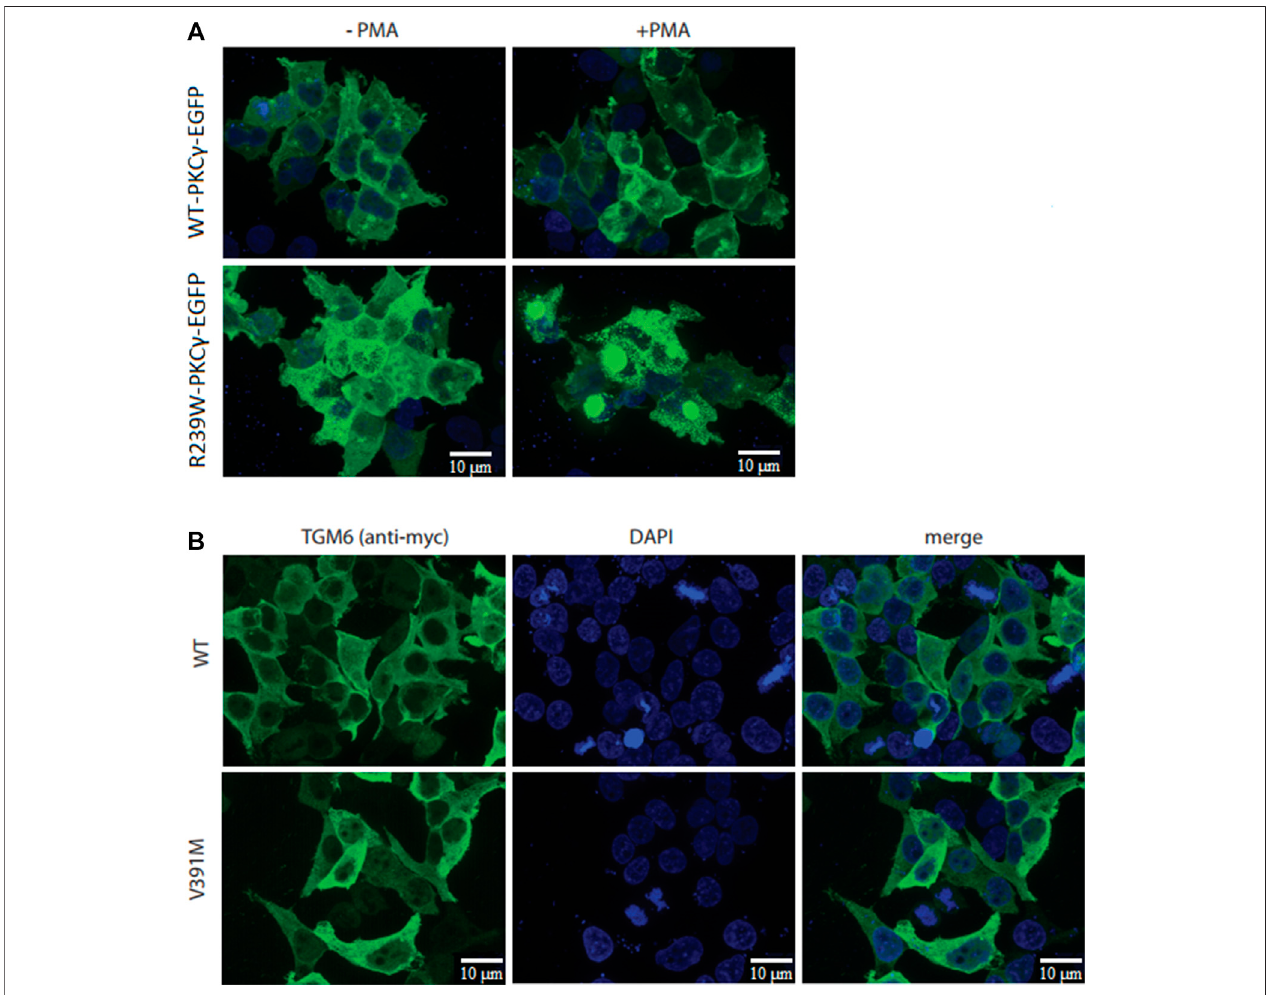
FIGURE 3 | Cellular studies of R239W PKC γ and V391M TGM6. (A) While PMA-induced translocation was observed for wild type PKC γ -EGFP, very little translocationwasobservedforR239W-PKC γ -EGFP. (B) ImmunocytochemistrydidnotshowanydifferenceinproteinlocalizationbetweenwildtypeTGM6andV391M-